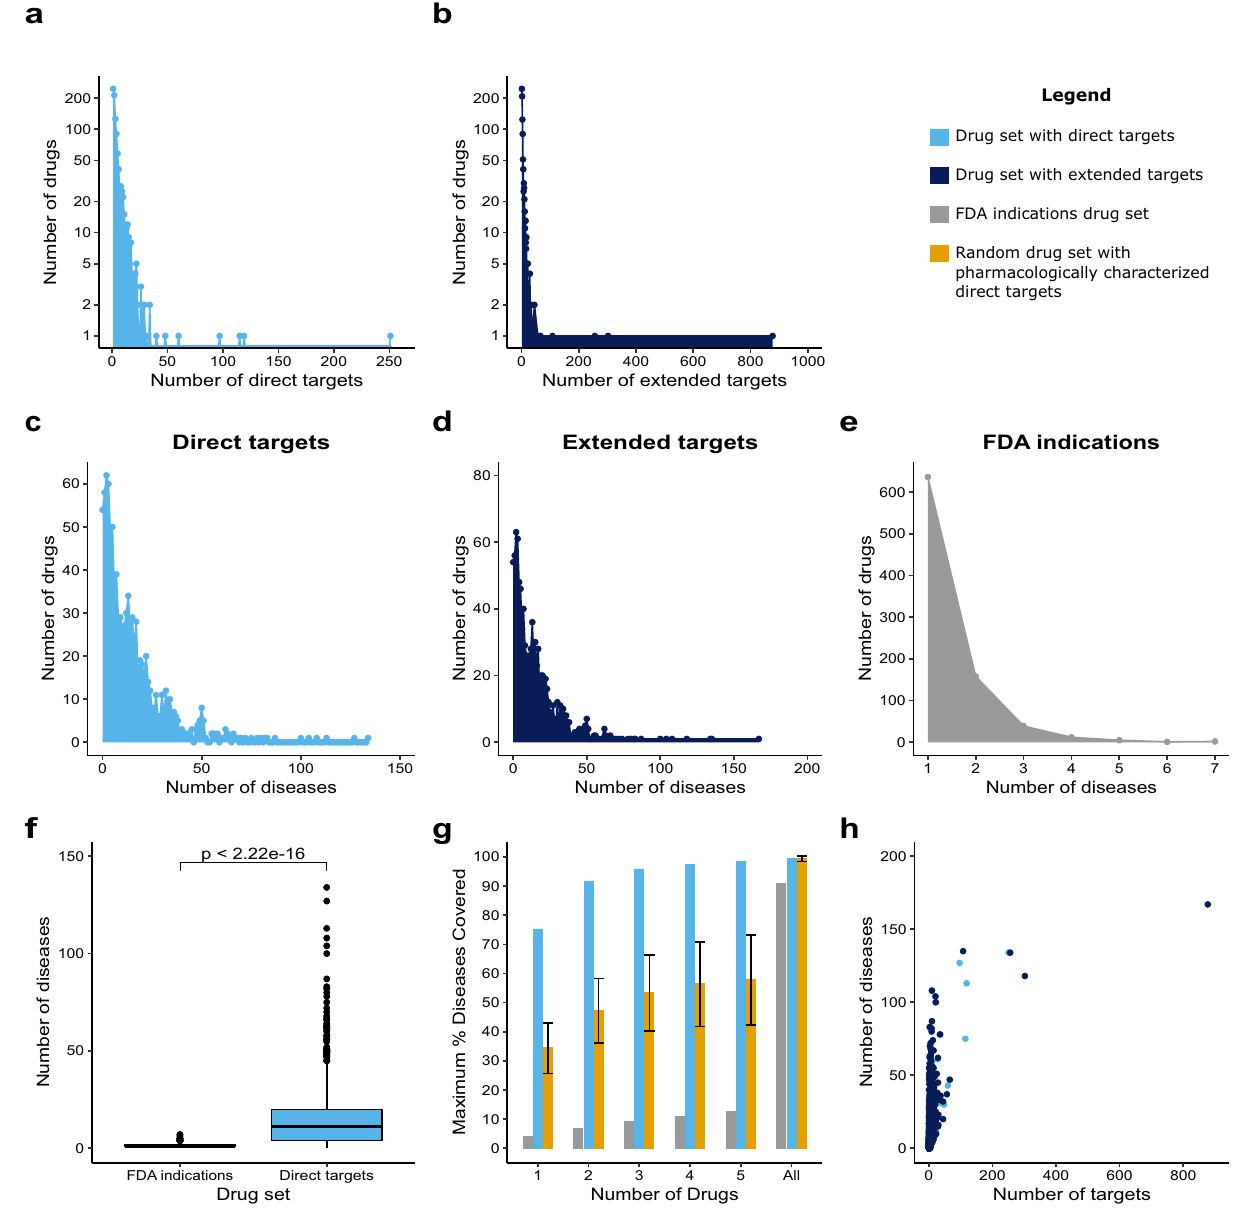
Figure 2. Drug repurposing may offer an average 11-fold increase of disease leverage. ( a ) Distribution of the number of genes targeted by FDA-approved drugs e.g., drug targets. ( b ) Distribution of the number of extended drug targets. ( c ) Distribution of the number of diseases covered by direct targets of FDA-approved drugs. ( d ) Distribution of the number of diseases covered by the extended targets of the drug set. ( e ) Distribution of the number of diseases targeted per drug for the “FDA indications” data set. ( f ) Statistical comparison of the distributions of disease coverage between the “FDA indications” data set and the direct drug target data set. ( g ) Quantification of the maximum number of diseases covered by 1, 2, 3, 4, 5 and all drugs for the “FDA indications”, the drug set with direct targets and a randomized version of the drug set. In the randomized drug set each drug has the same number of targets as in the original drug set, but the target genes are randomly chosen from the human genome. This random drug set represents the background levels of disease coverage. ( h ) Correlation between the number of targets and the number of diseases mapped to a drug. For the direct targets: rho = 0.636, p-value < 2.2 × 10 –16 . For the extended targets: rho = 0.644, p-value < 2.2 × 10 –16